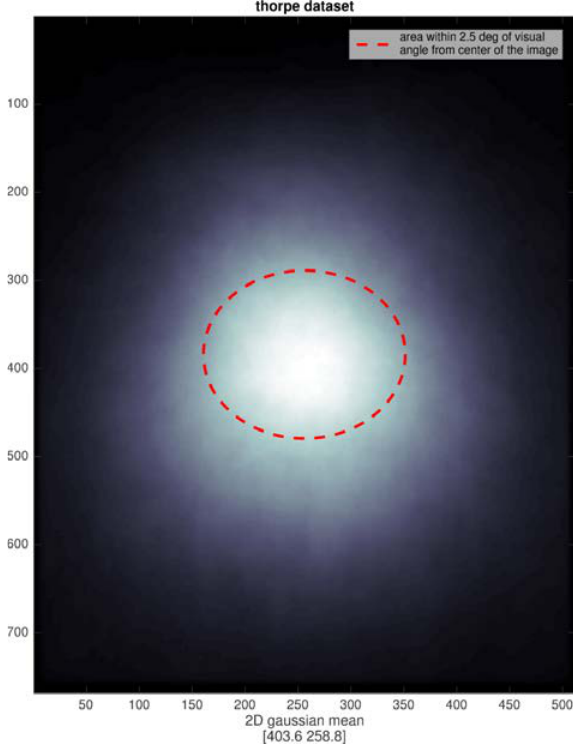
Figure 7. The distribution of targets in the Thorpe dataset. This was computed by first overlaying the binary ground truth masks and fitting a 2D Gaussian distribution to them treating pixels as z values.